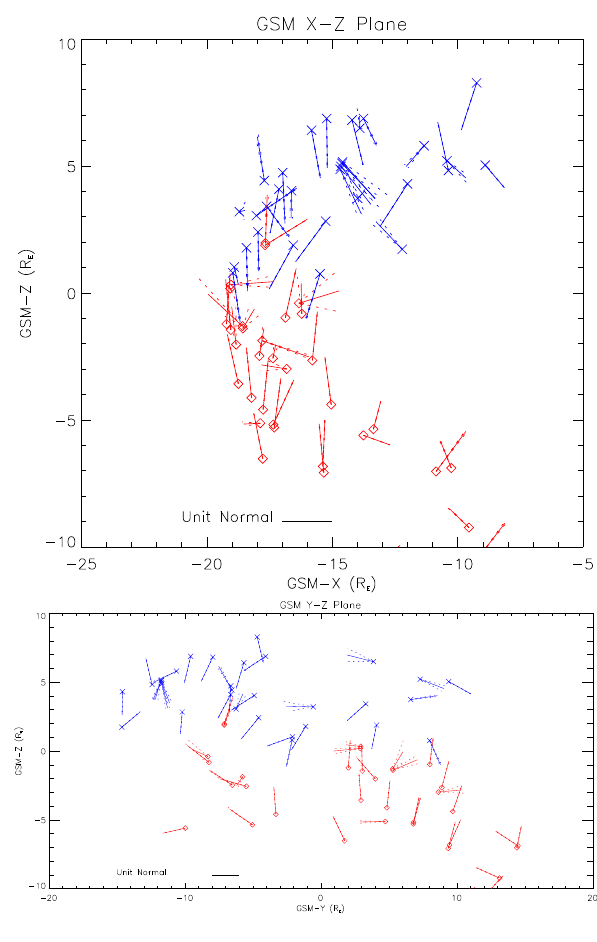
Fig. 9. For each passage of the spacecraft from the plasma sheet into the lobe on the GSM–YZ and GSM–XY planes, the projection of the lobe – plasma sheet boundary normal vector on that plane is shown, together with an estimate of the error associated with the spacecraft spin (dotted line). Those events in the Northern Hemi- sphere are shown in blue and those in the Southern Hemisphere are shown in red. A unit normal entirely in that plane is shown for refer- ence. In the Northern Hemisphere there is a tendency for the vectors to point towards the expected location of the current sheet, although there are notable exceptions where the GSM–Y component of the boundary normal is dominant. In the south lobe there is a less clear trend for the vectors to point to the current sheet, instead the vectors contain a mainly negative GSM–Y